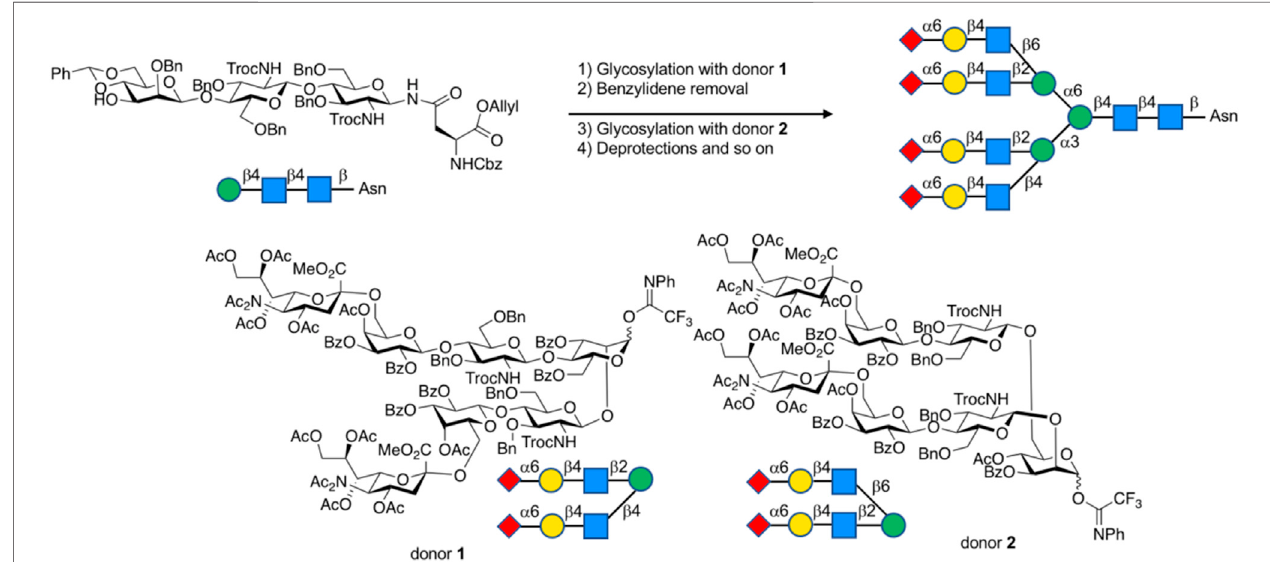
FIGURE 6 | Micro fl uidic assembly of complex-type N